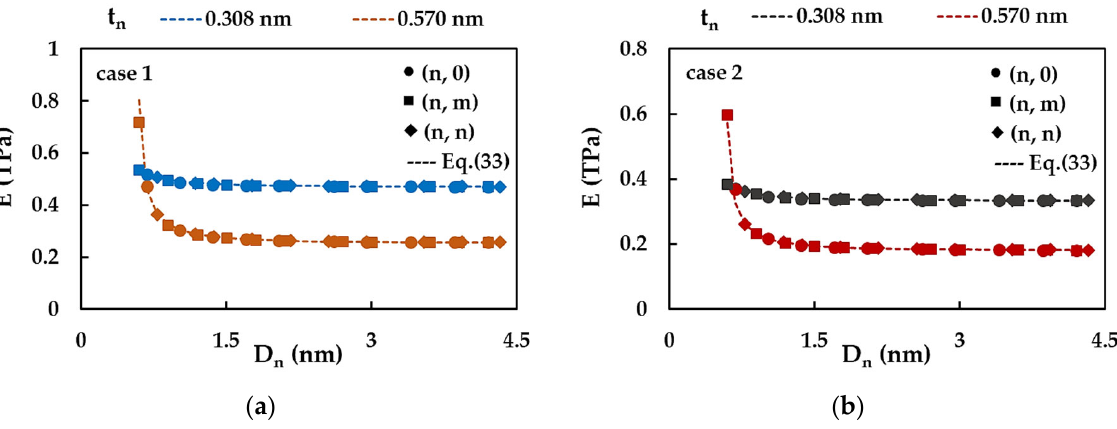
Figure 11. Evolutions of the Young’s modulus, E, with D n , for SWInNNTs, considering the nanotube wall thicknesses, t n = 0.308 nm and 0.570 nm: ( a ) Case 1; ( b ) Case 2.